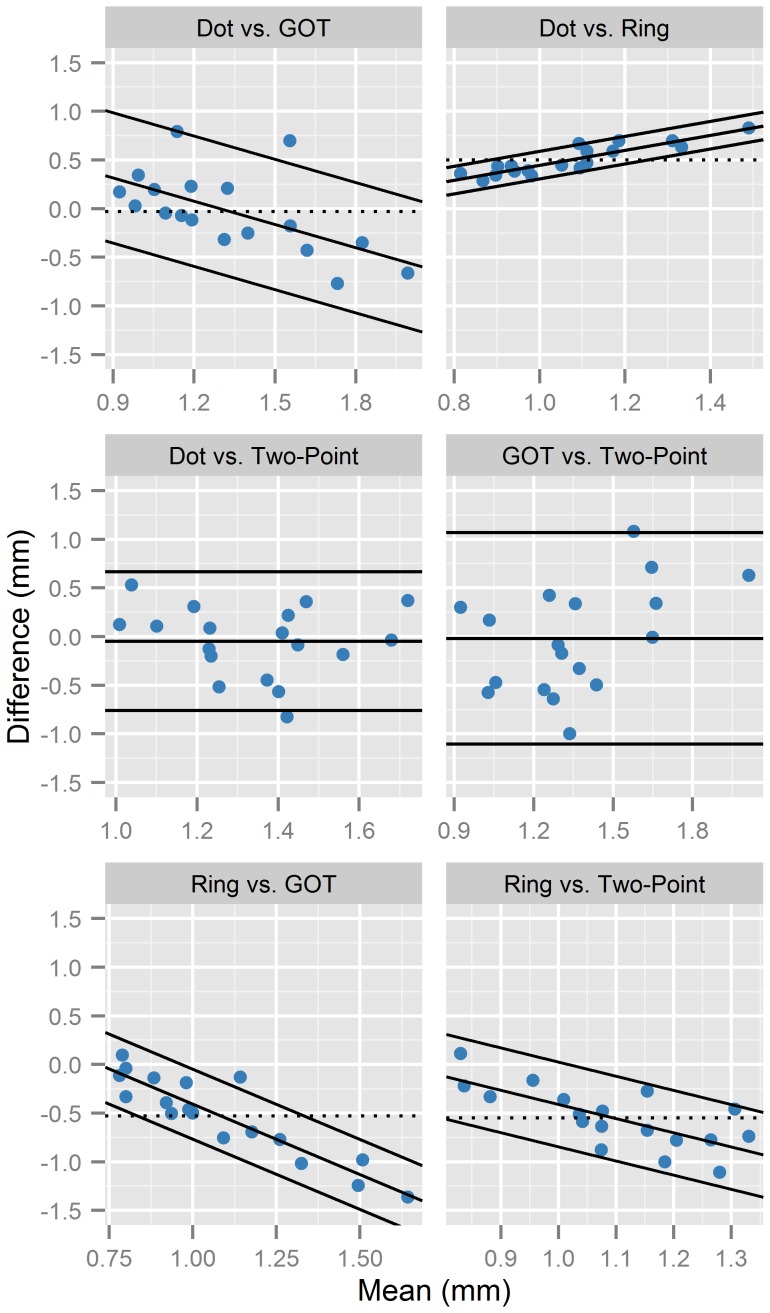
Pairwise comparisons between dot pattern and Landolt ring acuity charts, two-point thresholds, and GOT.For each of the six comparisons, m-d-plots show individual averages of the mean thresholds obtained by the two respective methods against their differences (last-mentioned minus first-mentioned method, respectively). Solid lines indicate 95% limits of agreement. For regression-based limits of agreement, dotted lines additionally indicate the mean differences between methods.